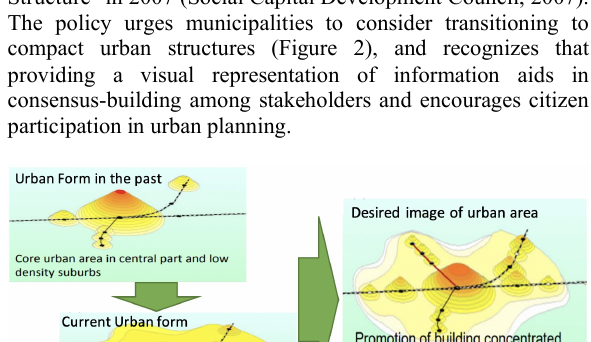
Figure 3. Cross Visualization of population and transportation